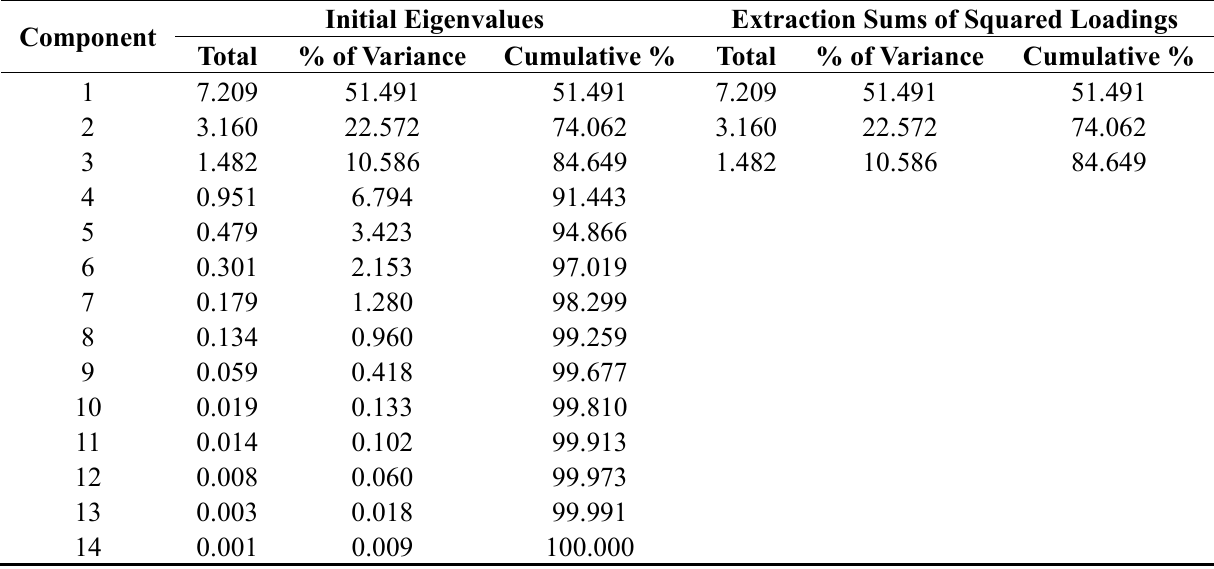
Table 5. The total variance explained for PCA of 14 elements in 18 batches of SO.